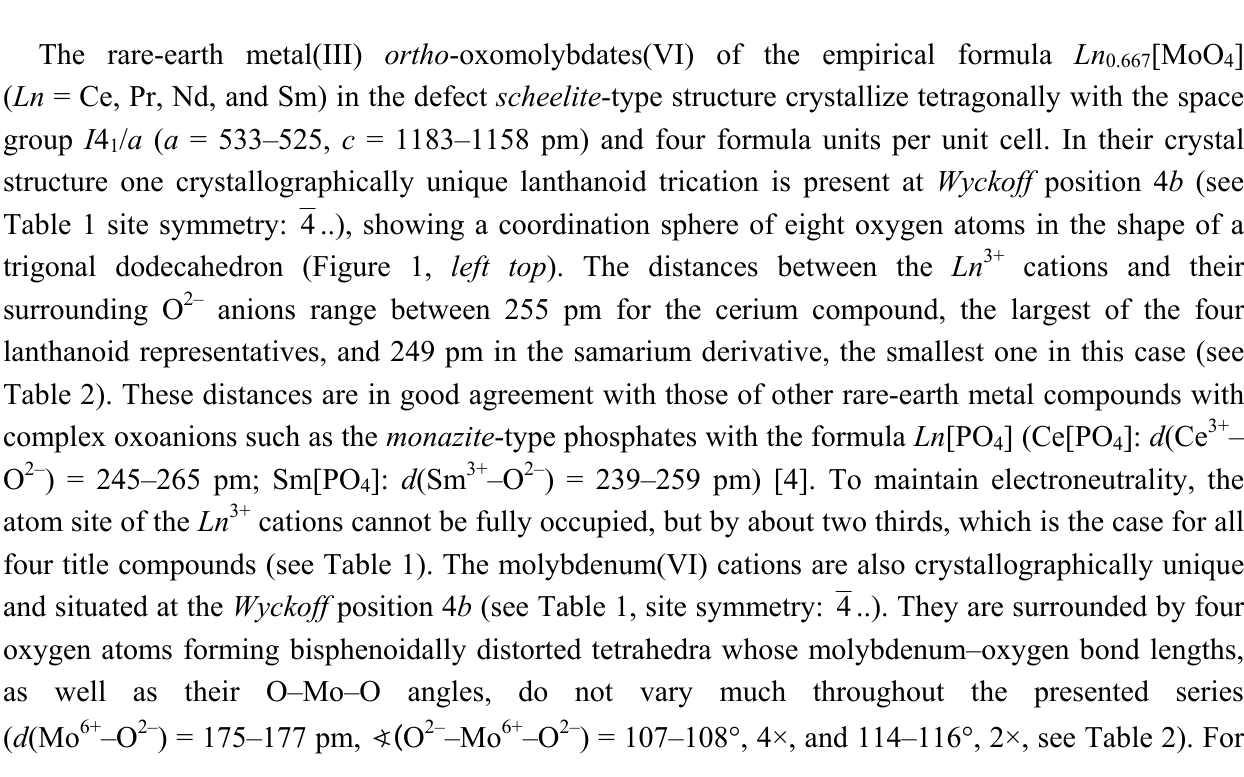
Table 1 site symmetry: 4 ..), showing a coordination sphere of eight oxygen atoms in the shape of